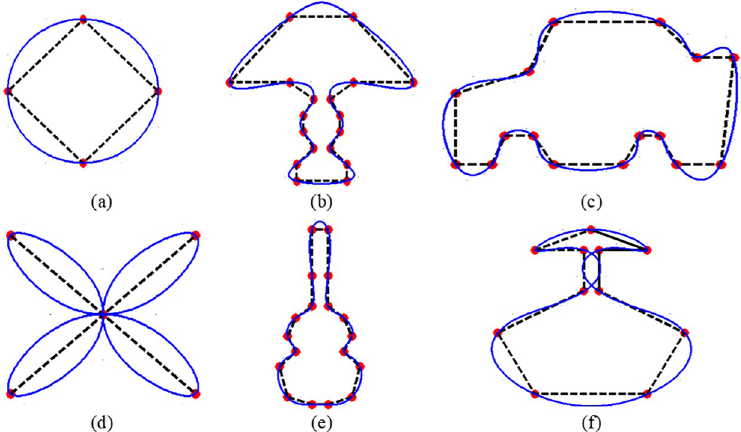
Fig 1. The data points of different objects (a) Circle, (b) Lamp, (c) Car, (d) Flower, (e) Guitar, (f) Vase, are interpolated by QTS with periodic end conditions. https://doi.org/10.1371/journal.pone.0208015.g001 PLOS ONE | https://doi.org/10.1371/journal.pone.0208015 January 10,